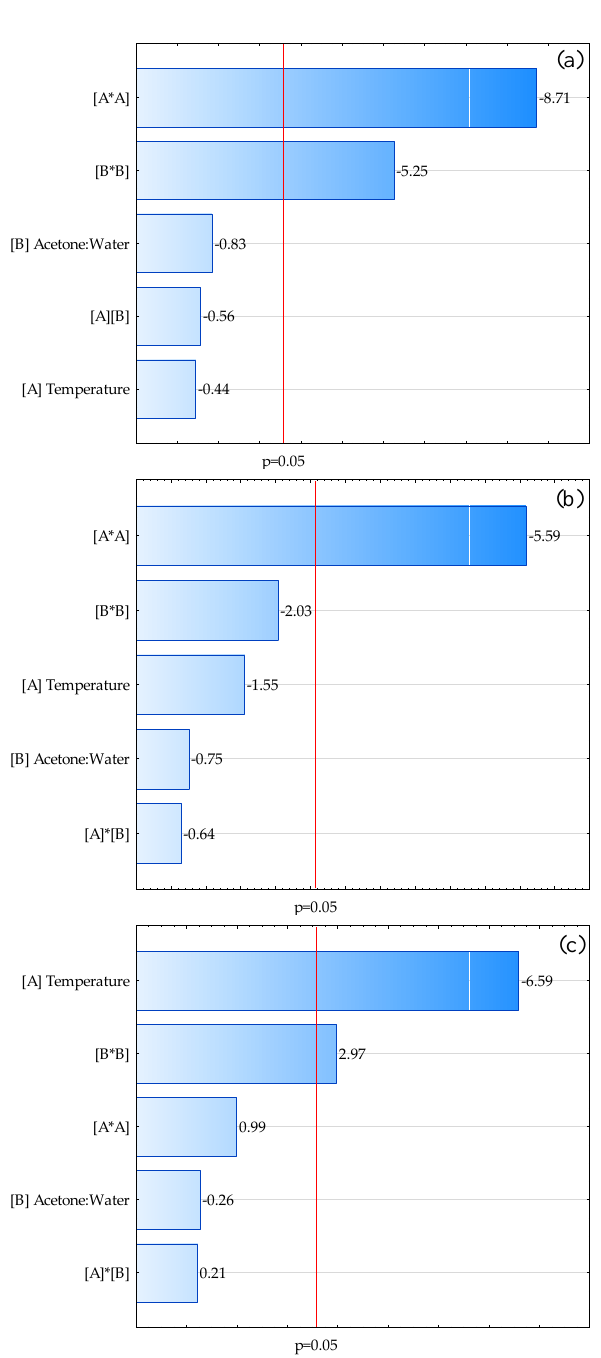
Figure 5. Pareto chart of estimated effects (blue bar) of the variables temperature (A) and acetone:water ratio (B) on HMF yield ( a ), HMF selectivity ( b ) and cellulose conversion ( c ).